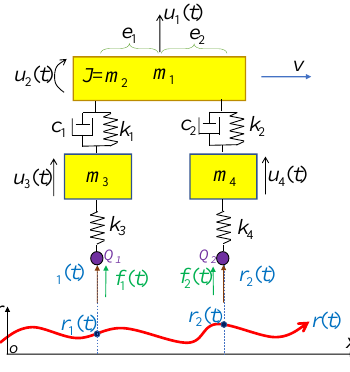
Figure 1. Half-car model of the vehicle.